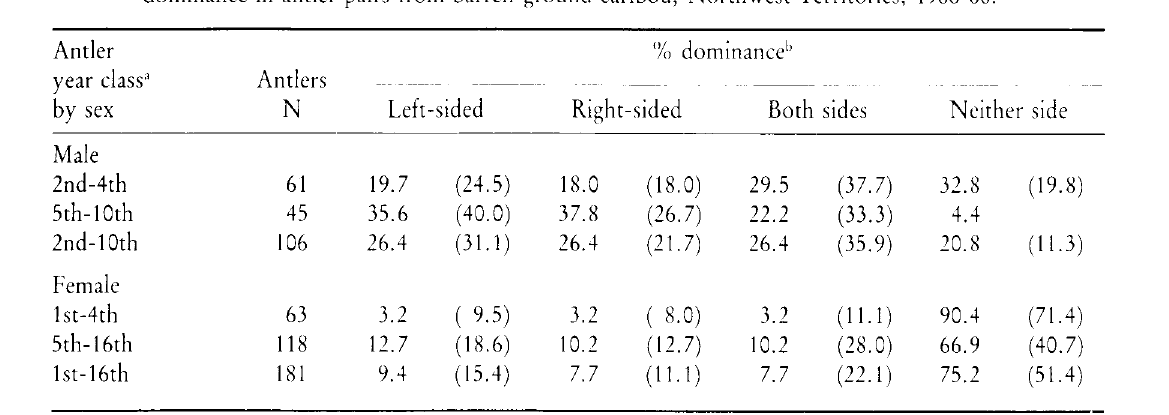
Table 1. Frequency of occurrence of brow tines or brow and bez tines together (brow/bez) as expressions of dominance in antler pairs from barren-ground caribou, Northwest Territories, 1966-68.